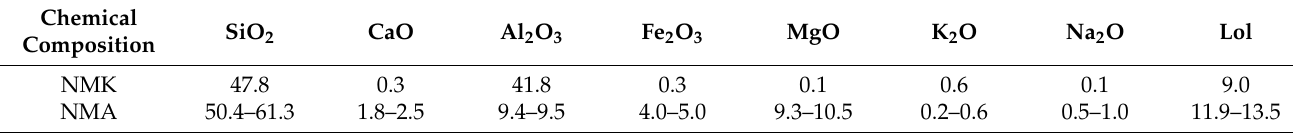
Table 1. Chemical composition of nano-clay (mass fraction, %).